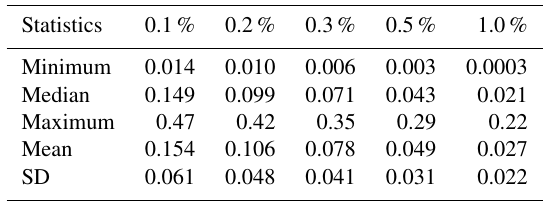
Table 4. Ranges, medians and means with SDs of the hygroscopic- ity parameter at supersaturations of 0.1%, 0.2%, 0.3%, 0.5% and